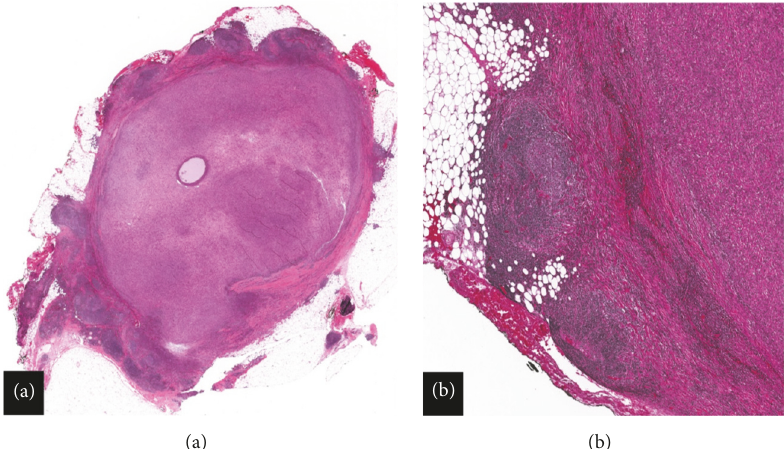
Figure 2: (a) Histology: whole mount section of a well-circumscribed mesenchymal proliferation with a prominent rimming lymphoid cuff, an incomplete eosinophilic fibrous pseudocapsule, and central cyst formation (Hematoxylin & eosin, 2X). (b) Histology: lymphoid cuff with germinal center formation and fibrous pseudocapsule (Hematoxylin & eosin,